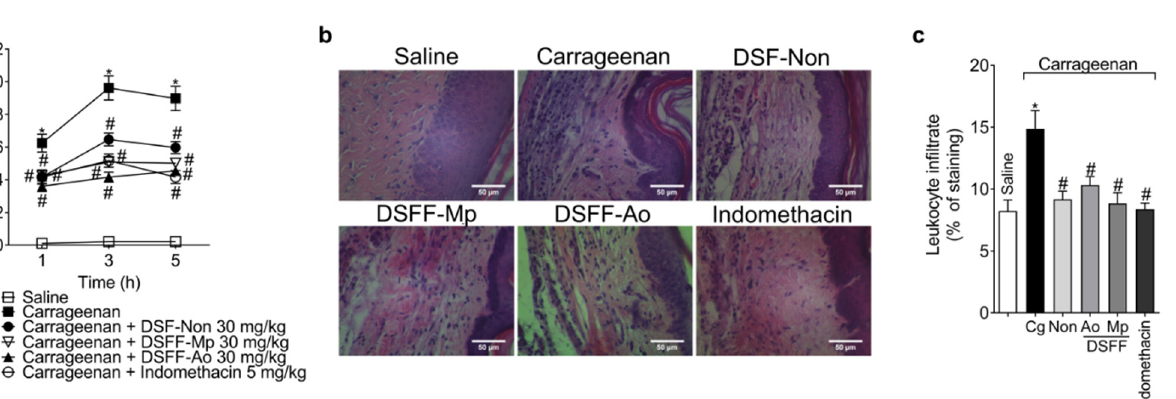
Figure 3. Evaluation of edema and leukocyte recruitment in carrageenan paw inflamma- tion. DSF-Non, DSFF-Mp, and DSFF-Ao (30 mg/kg) extracts inhibits ( a ) paw edema, ( b ), and ( c ) histopathology (leukocyte infiltration, scale bars indicate 50 μ m), ( d , scale bars indicate 100 μ m) and ( e ) eGFP + cells migration, and ( f ) MPO activity in the paw tissue. Indomethacin (5 mg/kg) was used as a positive control drug. Paw edema was evaluated 1, 3, and 5 h after and leukocyte recruitment experiments were conducted 5 h after carra- geenan i.pl. injection. Results are expressed as mean ± SEM of six mice per group per ex- periment and are representative of two independent experiments. * p < 0.05 vs. saline group; # p < 0.05 vs. carrageenan group.